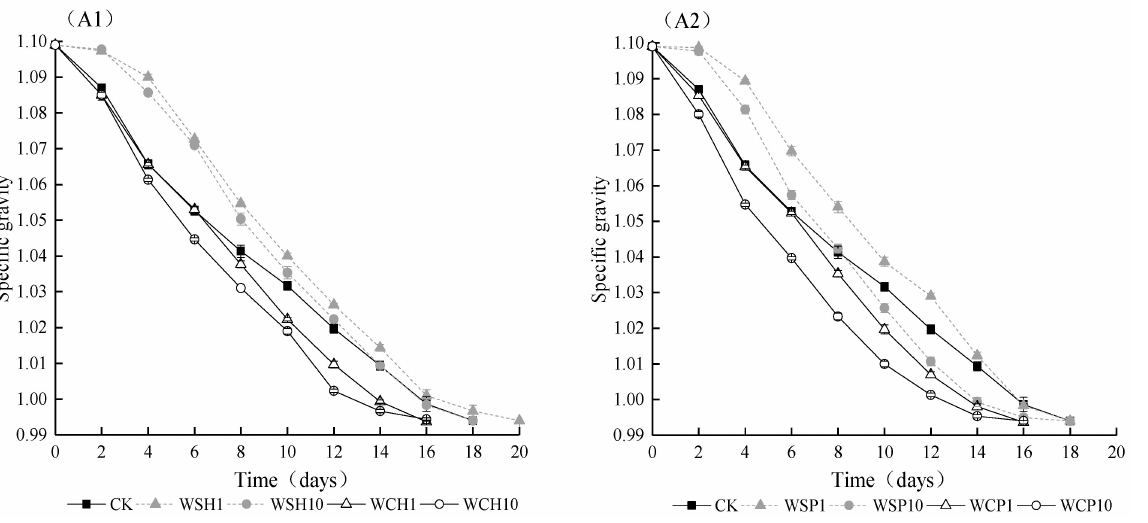
Figure 1. Fermentation curves of different treatments: ( A1 ) inoculation of Hanseniaspora uvarum , ( A2 ) inoculation of Pichia fermentans